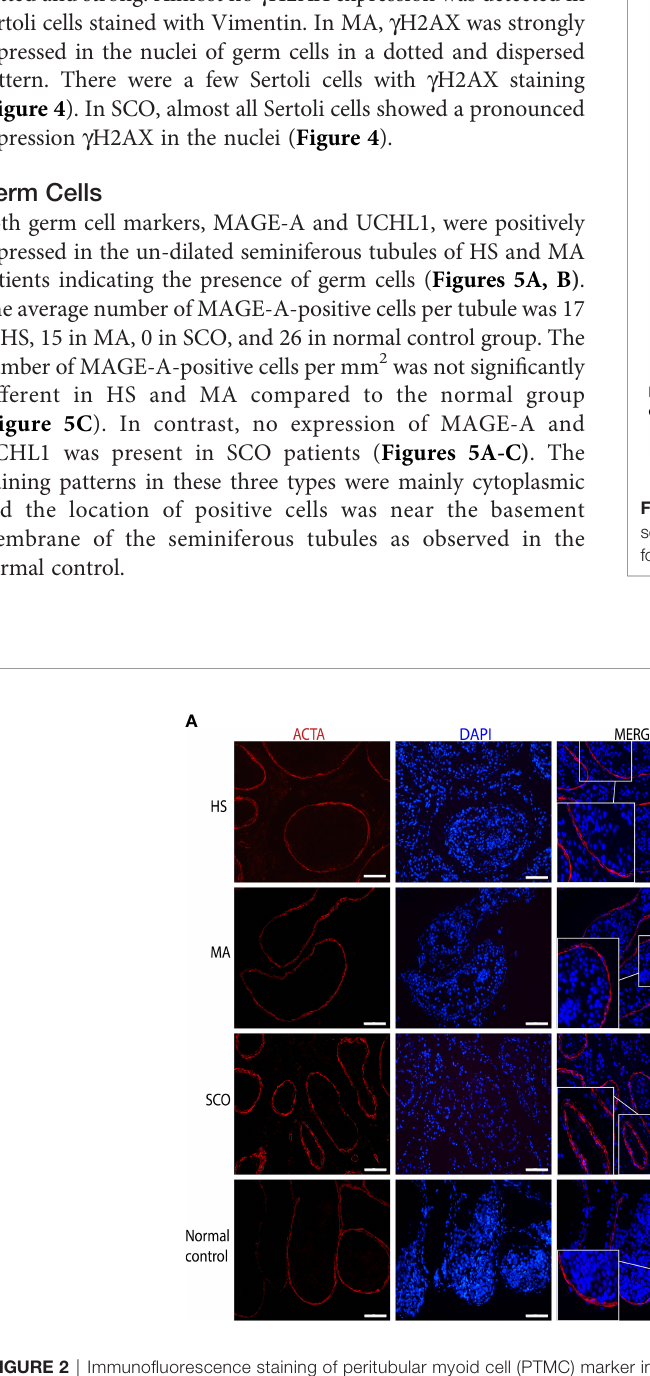
FIGURE 2 | Immuno fl uorescence staining of peritubular myoid cell (PTMC) marker in un-dilated seminiferous tubules from HS, MA, SCO, and NC samples. (A) Alpha-smooth muscle actin (ACTA) (red) for PTMC, DAPI (blue) for nuclear staining, Scale bar: 100 m m. (B) Thickness analysis of tubule wall. Asterisk indicated signi fi cant difference between SCO and normal control group (* p < 0.05).